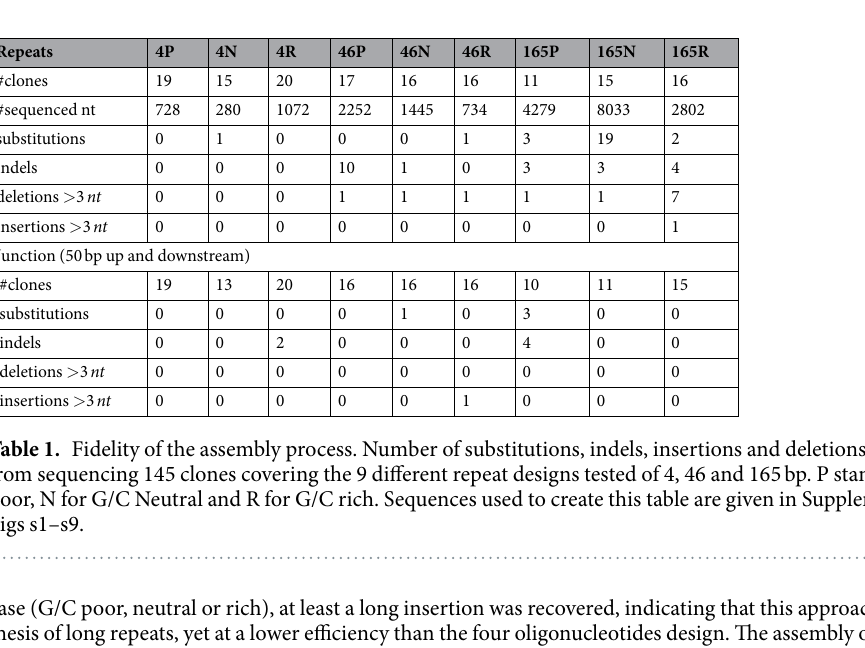
case (G/C poor, neutral or rich), at least a long insertion was recovered, indicating that this approach allows syn- thesis of long repeats, yet at a lower efficiency than the four oligonucleotides design. The assembly of 4 bp repeats led predominantly to short assembled repeats (5–10 repeats). As in the case of 46 bp repeats, assembly of 5–10 repeats can be explained by direct recombination of overlapping sequences within donor DNA without insertion of overlapping oligonucleotides. However, long insertion of up to 100 repeats were recovered from the assembly of 4 bp GC rich monomers, demonstrating that synthesis of large repeated arrays by oligonucleotide assembly is feasible in this context.